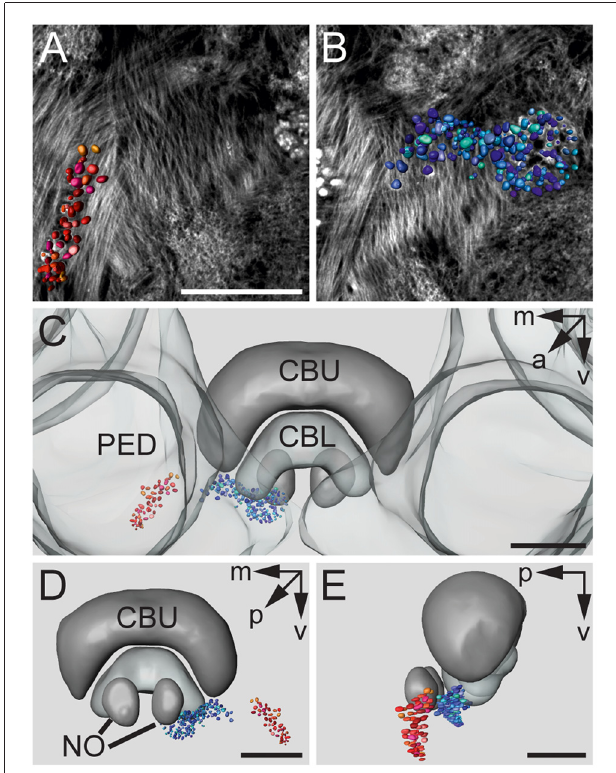
FIGURE 3 | 3D reconstructions of f-actin phalloidin labeled microglomerular synaptic complexes. (A) Reconstruction of the cluster (red) in the LBU. (B) Reconstruction of the synaptic complexes in the MBU (blue). (C) 3D reconstruction of the microglomerular synaptic complexes and their spatial distribution in relation to the PED and the CBU and CBL. (D) View from posterior reveals the distribution of the clusters in relation to the CB and the noduli (NO). (E) Sagittal view shows the location of the clusters in anterior-posterior axis extending to the NO. Scale bars: A,B = 50 µ m, C–E = 70 µ